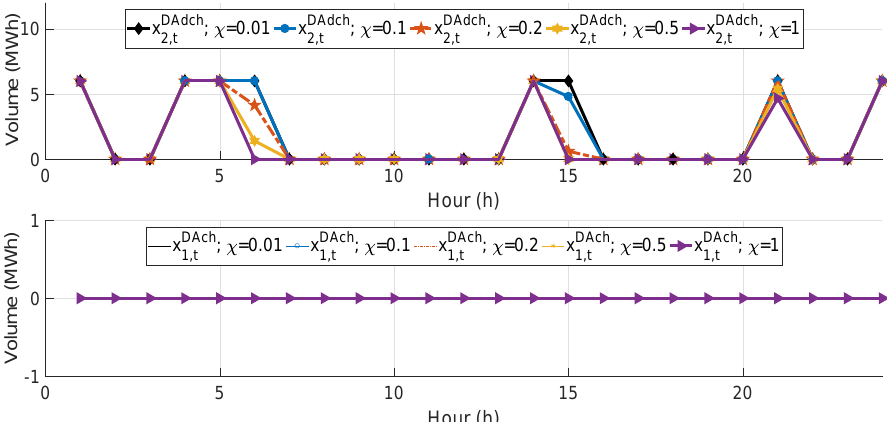
Figure 9. Day-ahead trading strategies; hourly conditional value at risk (T-CVaR) risk aversion shift in day-ahead bids of 24 h of planning day (upper figure-discharging bids, lower figure-charging